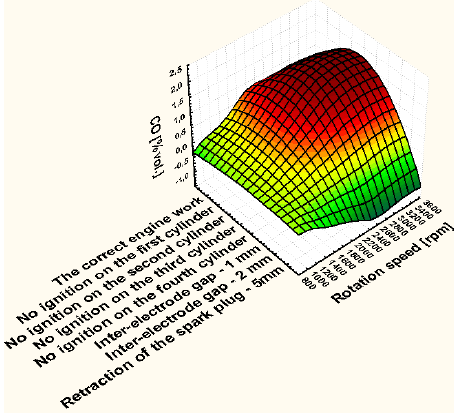
Fig. 25. The carbon monoxide content of the Fiat 1.1 petrol-powered